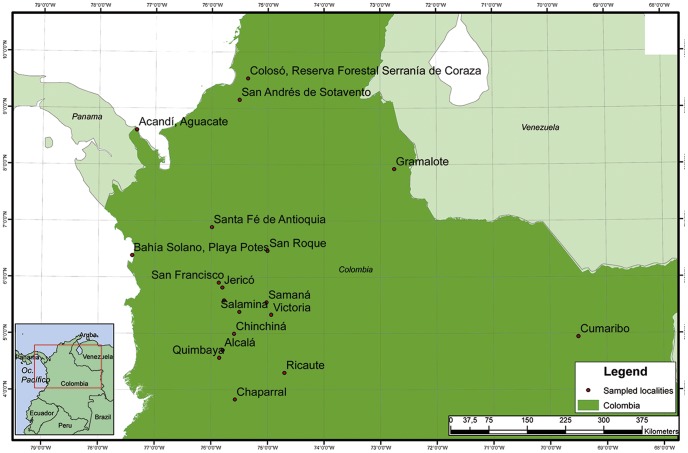
Map of the study area showing the sampling sites of sand flies collected in the present study.Site 1: Jardín; Site 2: Jerico; Site 3: San Francisco; Site 4; San Roque; Site 5: Santa Fé de Antioquia; Site 6: Chinchina; Site 7: Salamina; Site 8: Samaná; Site 9: Victoria, Site 10: Acandí; Site 11: Bahía Solano, Playa Potes; Site 12: San Andrés de Sotavento; Site 13: Ricaute; Site 14: Quimbaya; Site 15: Gramalote; Site 16: Colosó, Serranía de Coraza Forestry Reserve; Site 17: Chaparral; Site 18: Alcalá; and Site 19: Caño Ariba.